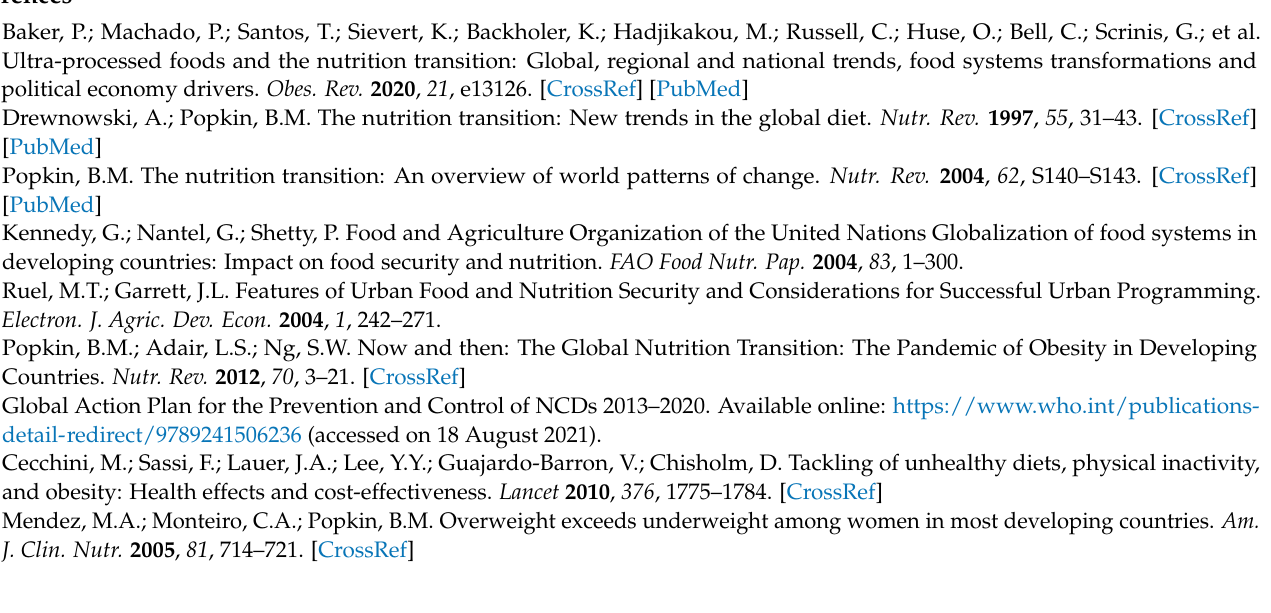
panel) and children (bottom panel), who consume an adequate quantity of fibre based on the recommended standards. Table S1: Food portion sizes estimated for the main food items. An average standard composition of t ô sauce was included in our calculation. For bouillie, an average composition was calculated (for 100 g of dry product: millet 60 g, soy 20 g, peanuts 10 g, sugar 9 g). Table S2: Living conditions of the households enrolled in the three different environments. Table S3: Estimation of macronutrients intake in adults of the three cohorts. Data are reported as median and interquartile range (IQR). Table S4: Estimation of macronutrients intake in children of the three cohorts. Data are reported as median and Interquartile range (IQR). For fibre, absolute amount in grams is not reported due to differences in age and weight of children. Table S5: Comparison of the weekly frequency of meals not prepared at home among the three cohorts, in particular food consumed at restaurant and food from a local market. Table S6: Adult BMI divided by gender. Median and IQR are